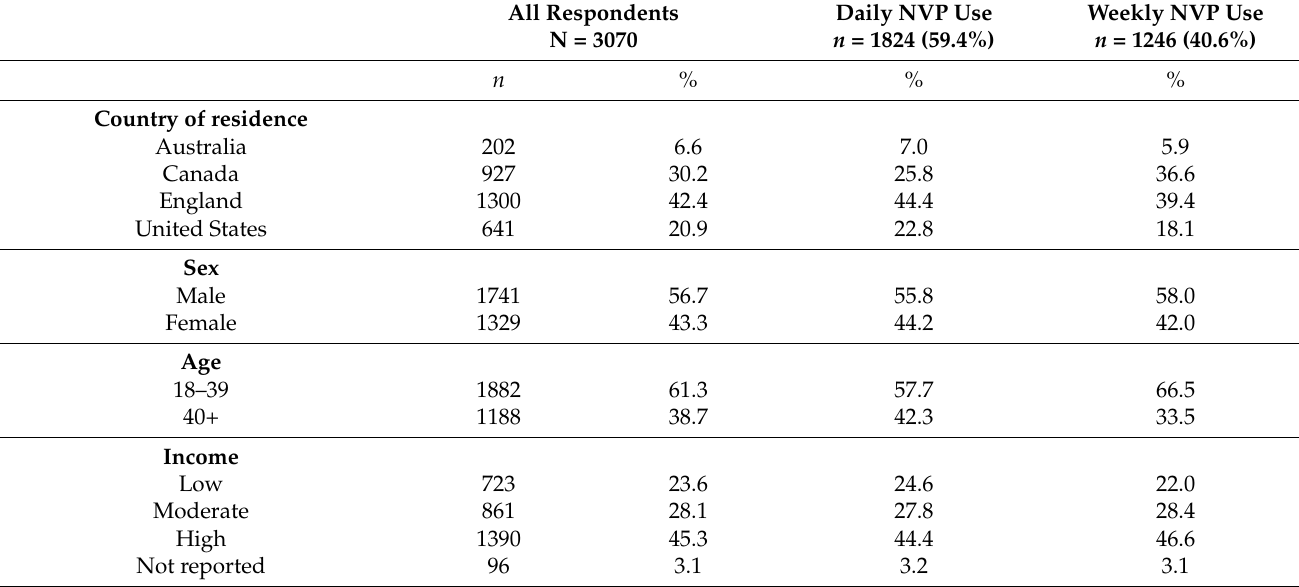
Table 1. Respondent characteristics ( n , unweighted %) of the study sample, Wave 3